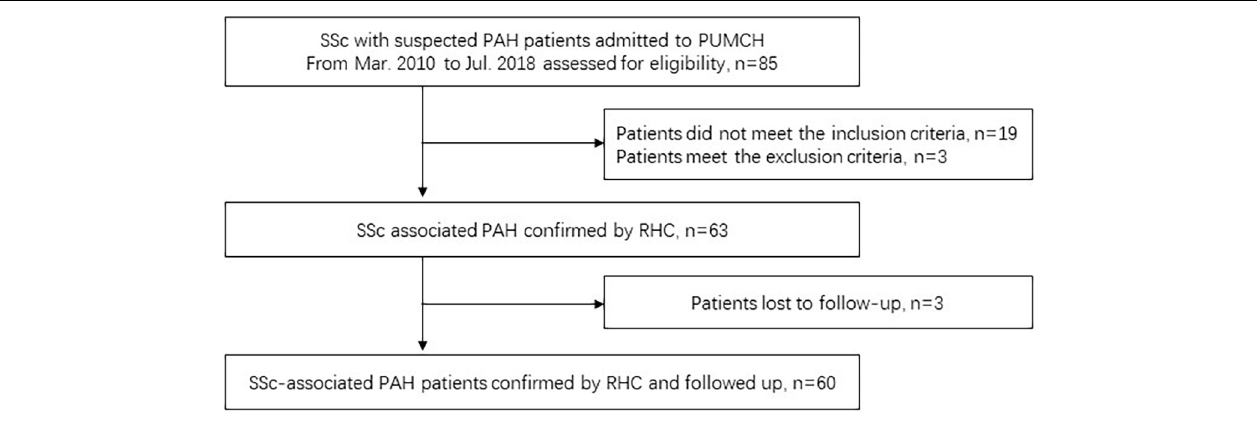
FIGURE 1 | Flowchart of patient screening. SSc, systemic sclerosis; PUMCH, Peking Union Medical College Hospital; RHC, right heart catheterization.